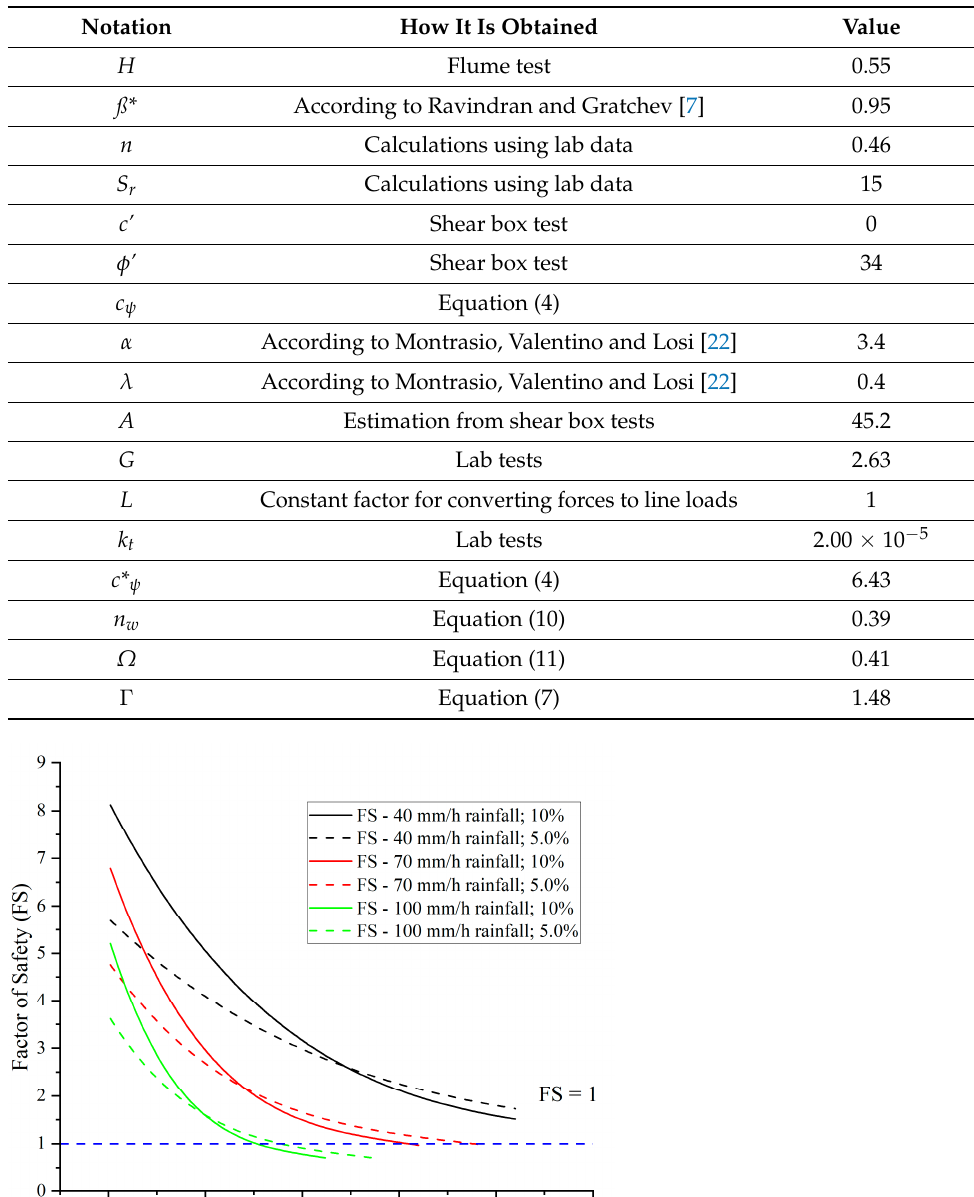
Table 2. The input parameters for the numerical model.